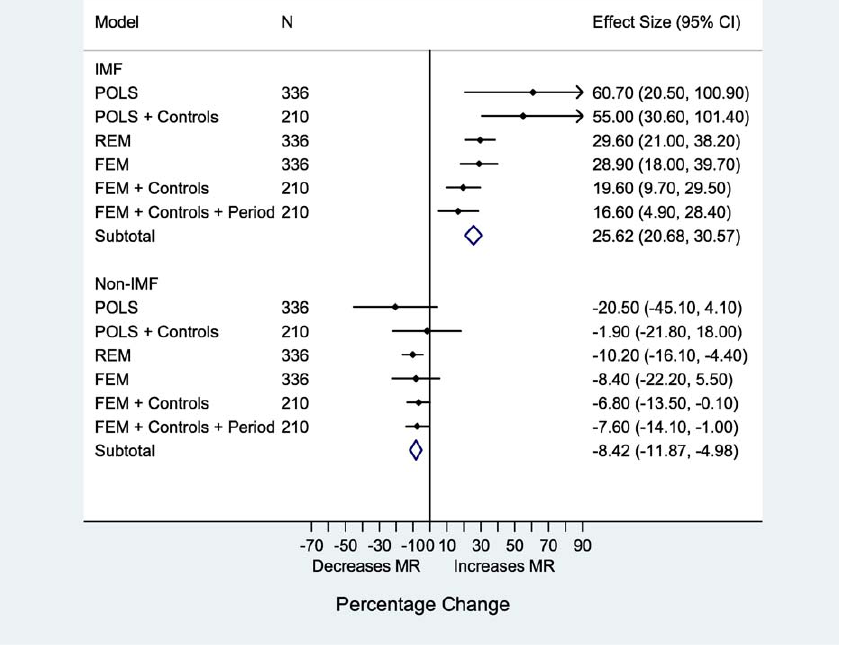
Figure 4. Forest Plot: Effects of IMF and Non-IMF Debt on Log Tuberculosis Mortality Rates Results based on six separate regression models using various controls and functional forms. Weighting used for aggregation calculated based on confidence intervals provided in STATA’s standard metan module. Controls include either IMF or non-IMF program, change in log GDP, level of log GDP per capita, democratization index, dummy for occurrence of military or ethnic conflict, population dependency ratios, percentage of the population with tertiary education, and urbanization rates. CI, 95% confidence interval; FEM, fixed effects model, which uses a set of country dummies; POLS, pooled OLS model; REM, random effects model. ‘‘ Period ’’ refers to a set of year dummies.